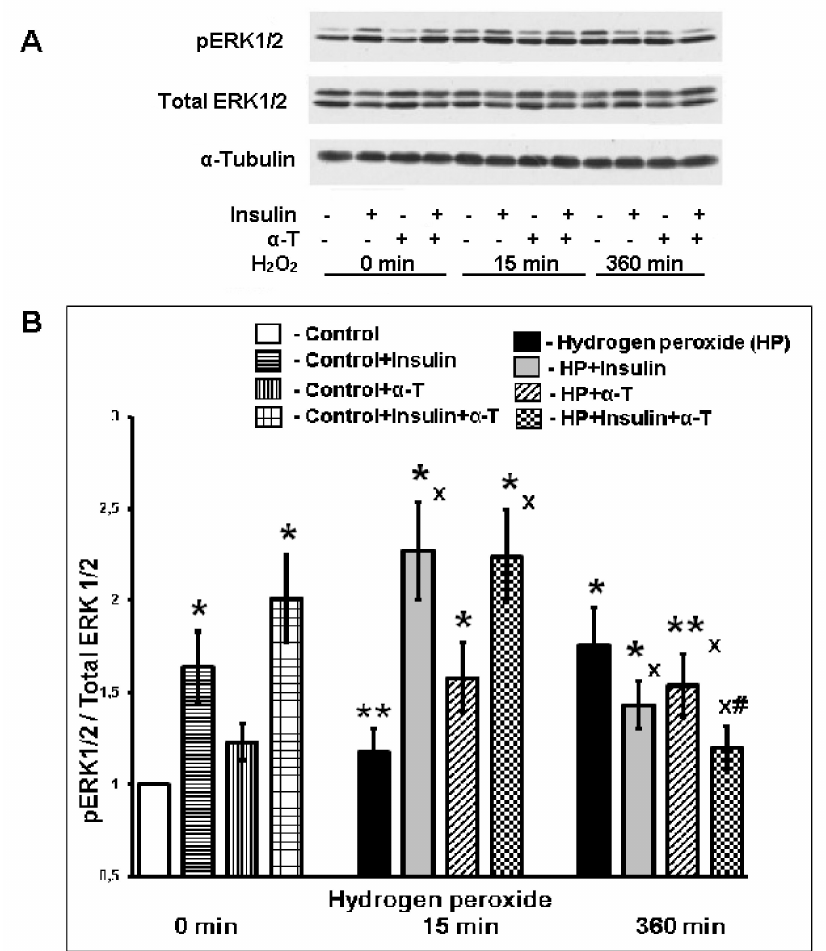
Figure 6. The effect of hydrogen peroxide, insulin and α -T on the activity of ERK1/2 (pERK1/2/ERK1/2 ratio) in brain cortical neurons. ( A )—immunoblots of pERK1/2 and total ERK1/2 are shown; ( B )—the data of 6 experiments are presented as the means ± SEM. The brain cortical neurons were pre-incubated for 1 h with 1 µ M insulin or for 18 h with 50 µ M α -T, with both drugs or without them. Then the neurons were exposed to 100 µ M hydrogen peroxide for 0, 15 and 360 min. The differences are significant according to Student’s paired t -test as compared: * and **—to the control, * p < 0.02, ** p < 0.05; x—to the effect of hydrogen peroxide alone, p < 0.01, #—to the effect of insulin or α -T alone, p <